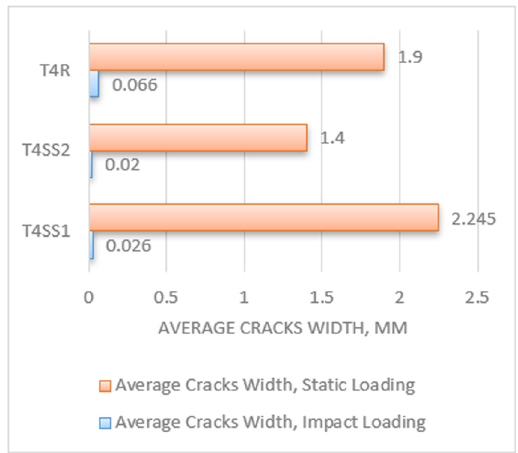
Figure 19: Average crack width of the slabs under the e ff ect of loads of impact and